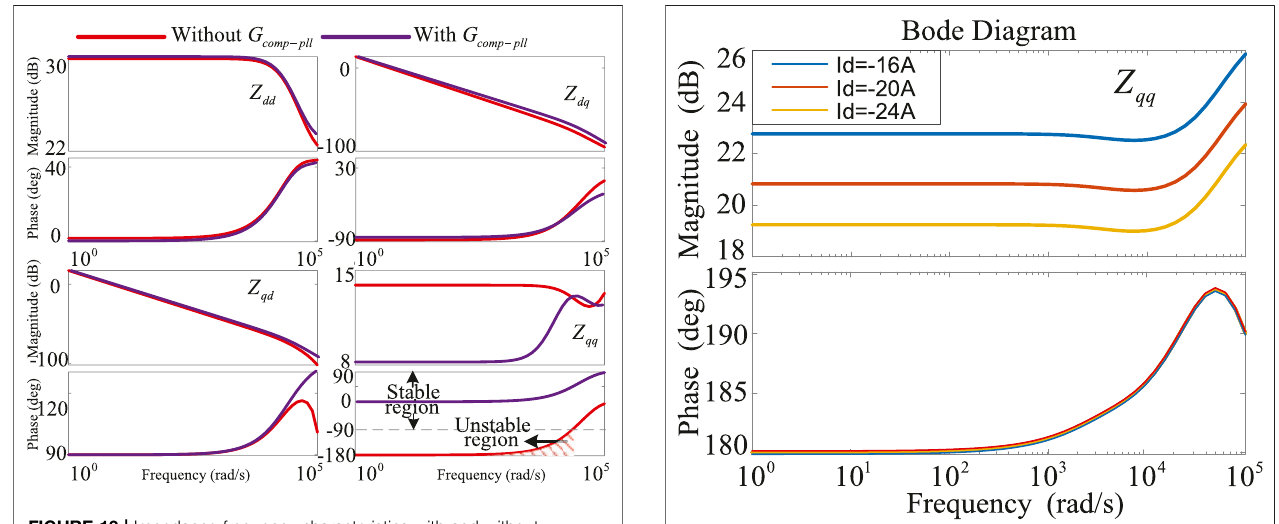
FIGURE 13 | Impedance frequency characteristics with and without G comp − pll . FIGURE 15 | Frequency characteristics of Z